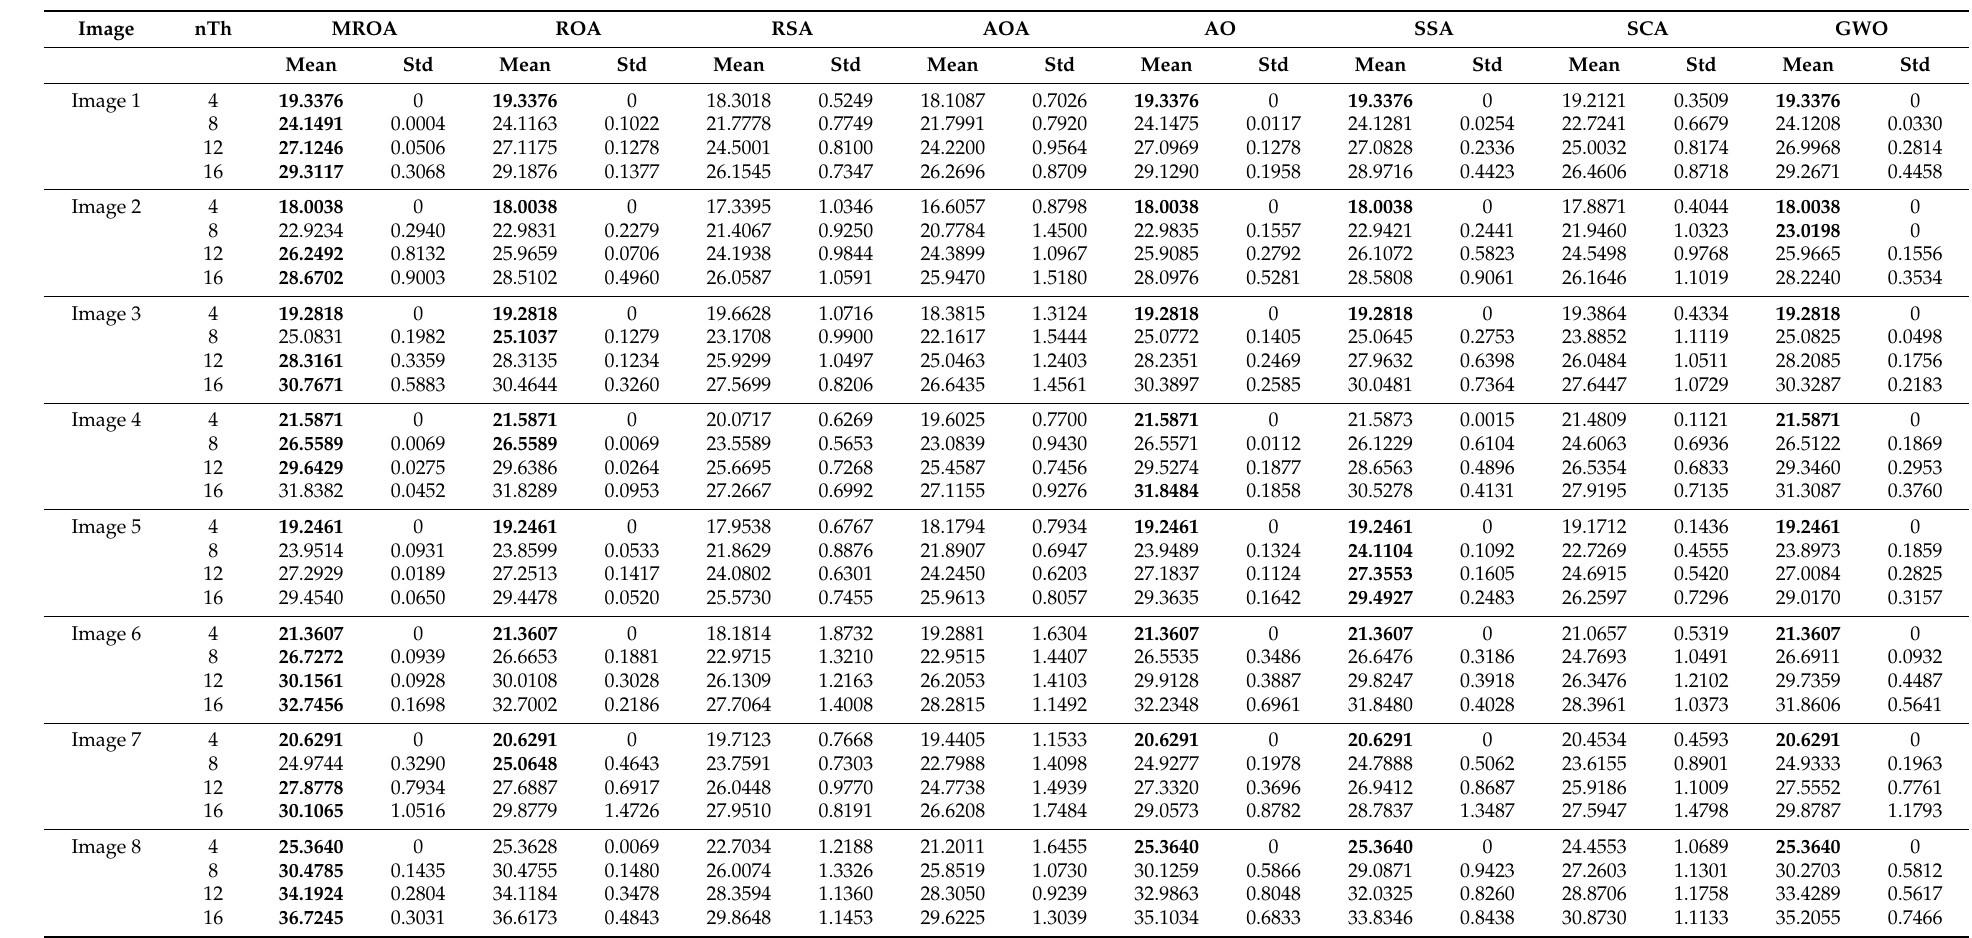
Table A4. The PSNR values obtained by algorithms over all